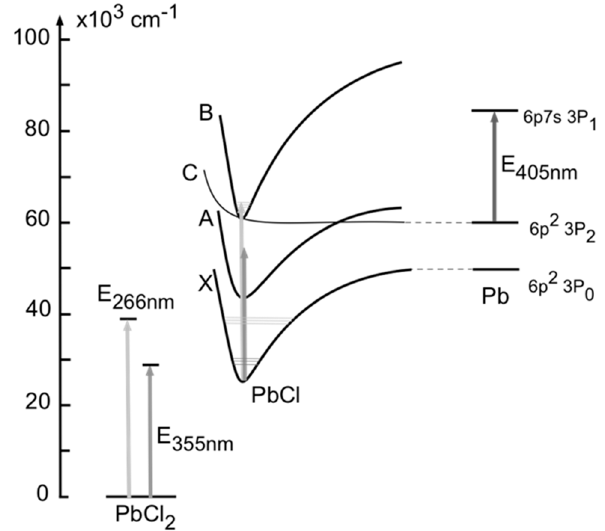
Figure 2. Simplified energy levels diagram for PbCl molecules and Pb atoms adapted from [35]. The Pb transition associated with the optical absorption of light at 405.79 nm involved the excited states 6p2 3 P 0 and 6p7s 3 P 1 . According to the diagram, the 6p2 3 P 0 level of Pb atoms can be achieved upon a double photodissociation process of PbCl 2 molecules using laser pulses at 355 nm and 266 nm wavelengths.